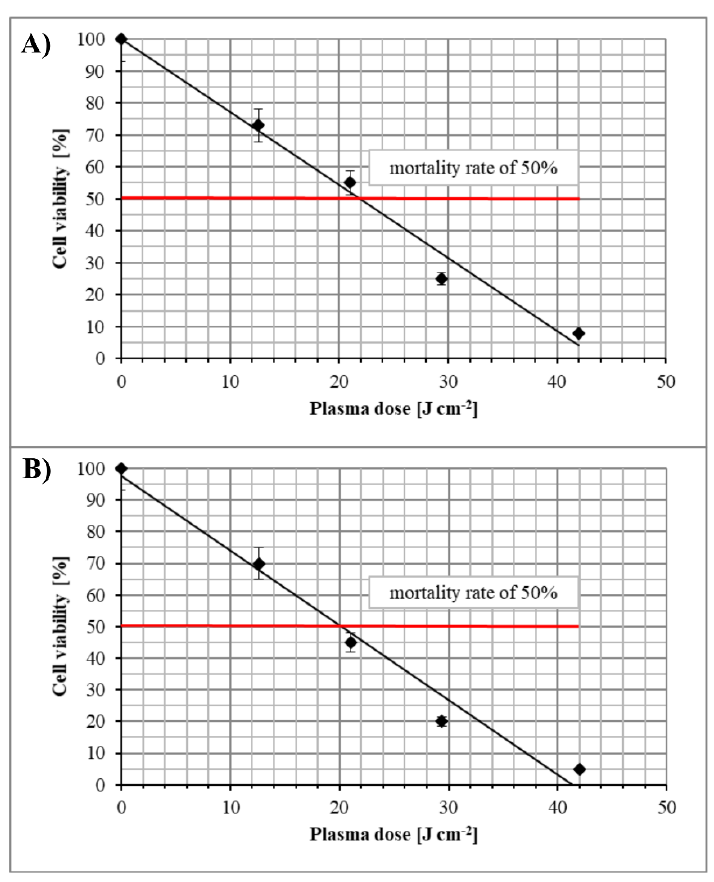
Figure 4. The effect of nonthermal plasma on the destruction of viable microbial cells forming fouling after 24-h contact of the activated sludge with: ( A ) polyamide membrane (PA); ( B ) cellulose acetate membrane (CA).